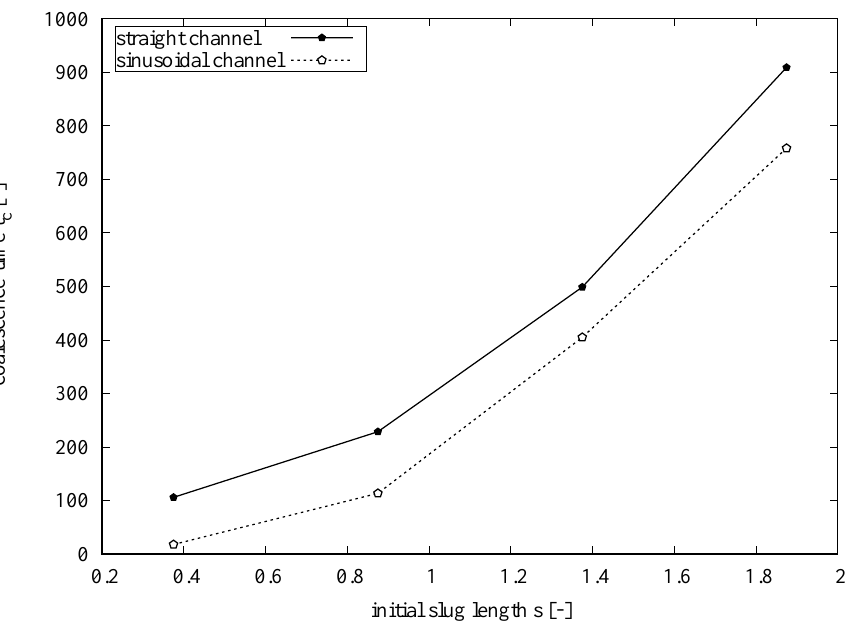
Figure 11. Trend of the coalescence time relative to the initial slug length s for the straight and sinusoidal channels. For initial slug length s ≥ 0.875, the coalescence time increases linearly as s increases. All parameters are